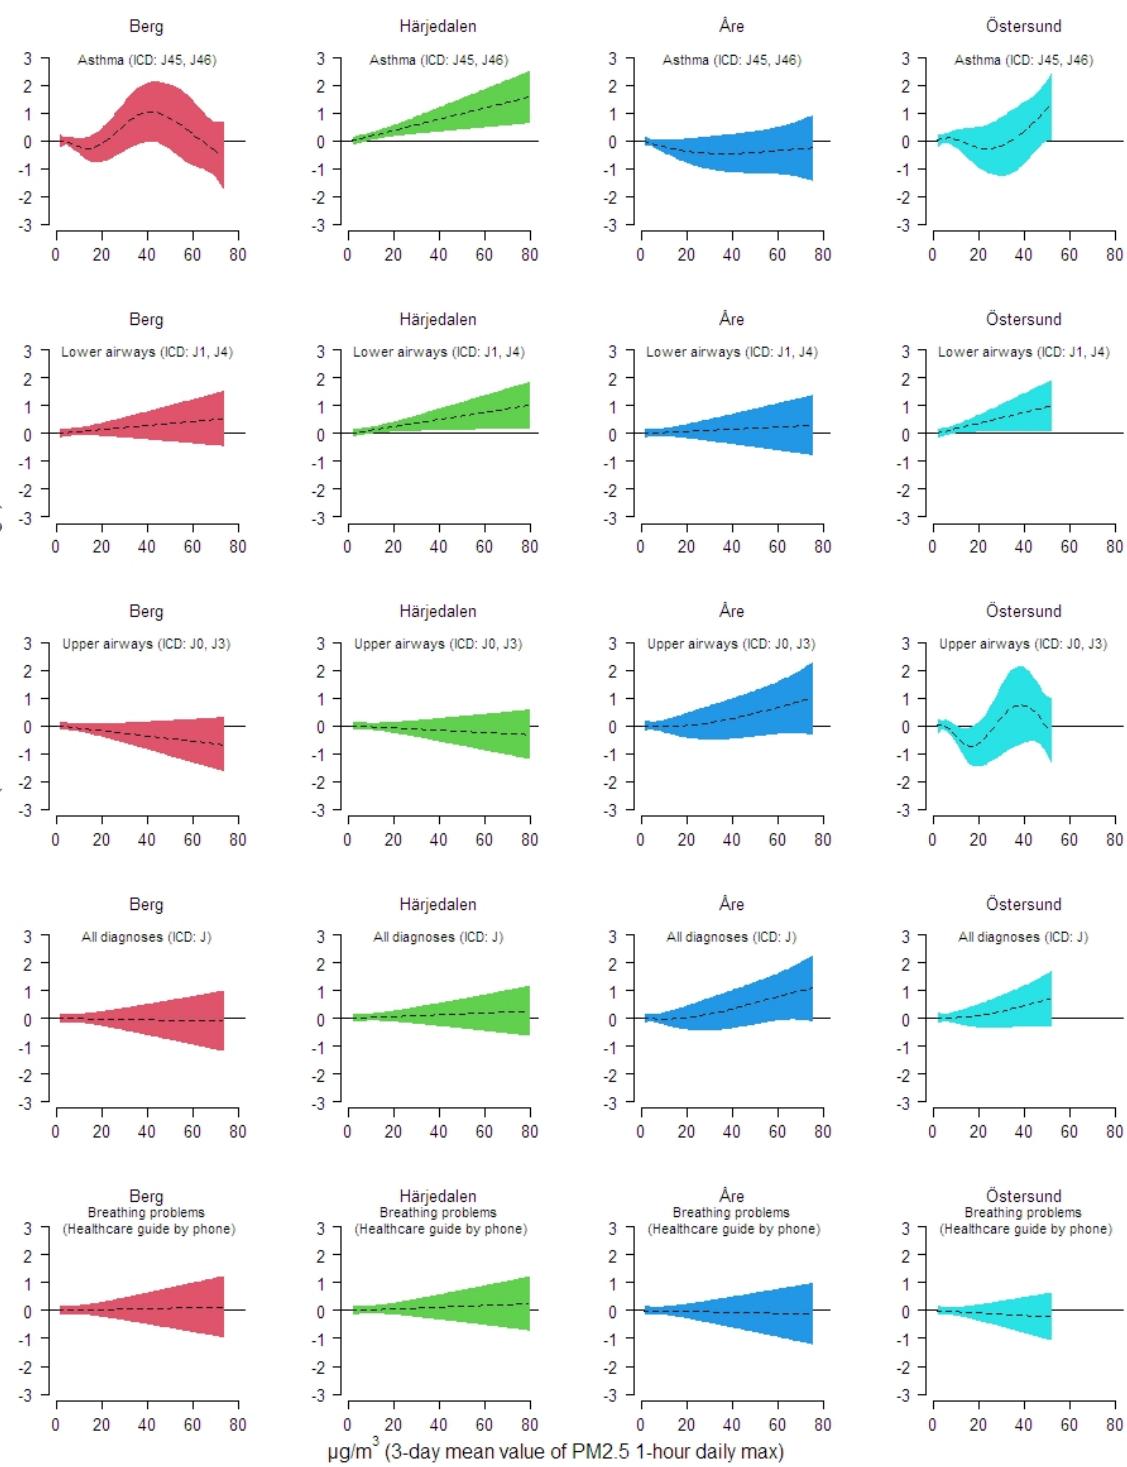
Figure 5. Associations between modelled exposure to PM 2.5 and different healthcare contacts (trend- and covariate adjusted residuals) in the four municipalities in the Jämtland Härjedalen region which were most exposed of smoke from wildfires summer of 2018.